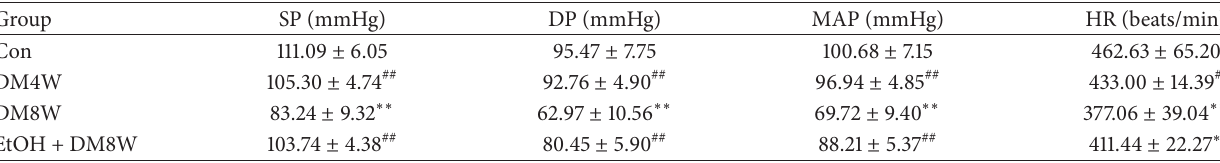
Table 1: Hemodynamic data in rats.